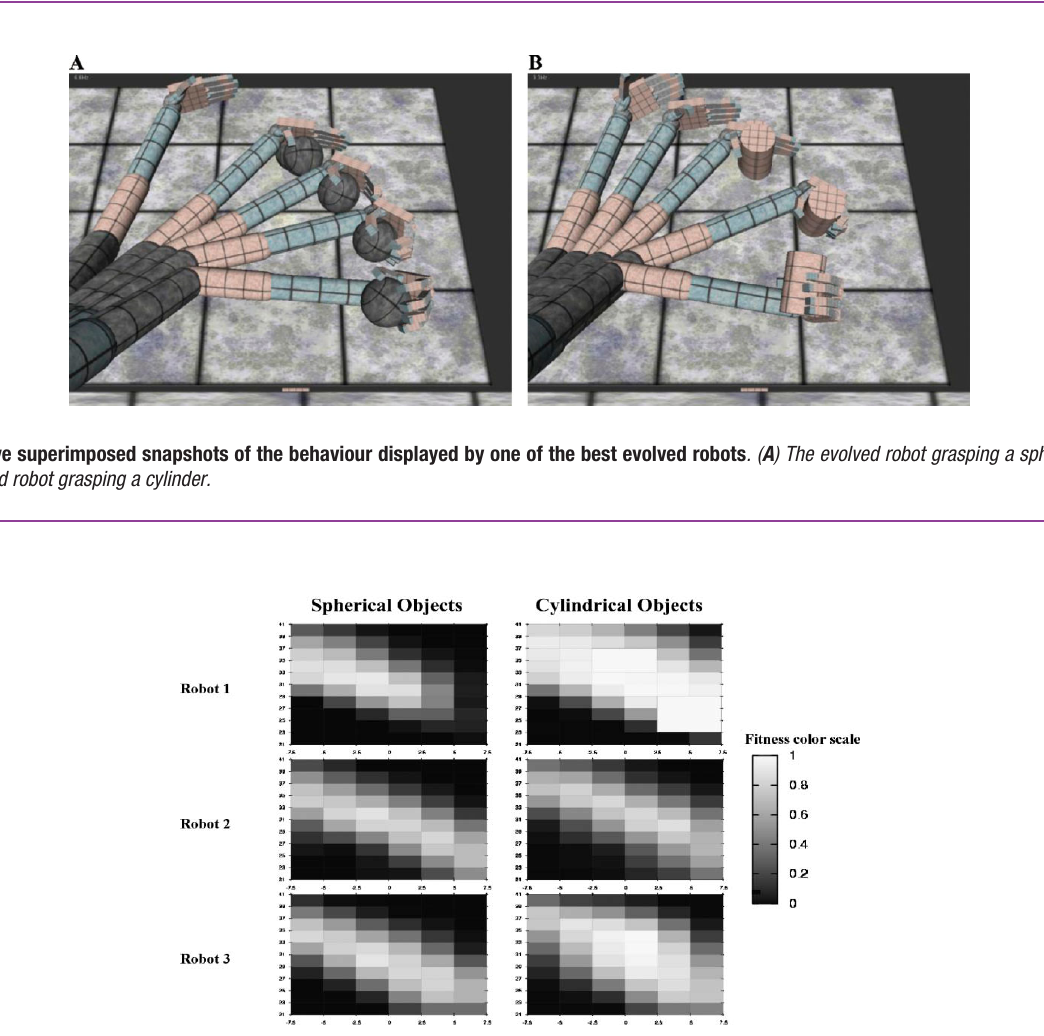
Figure 7. Performance of the best evolved robots of the three best replications of the